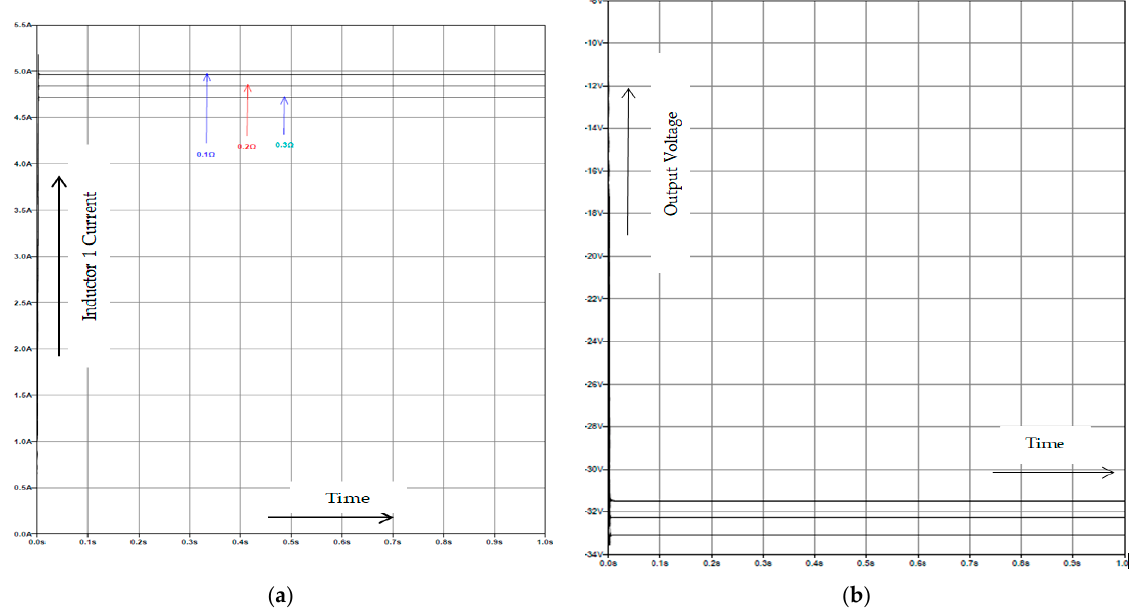
Figure 12. Variation of iL1 and V 0 with change in R L (Cuk). ( a ) Output Voltage Vs. Control Voltage, ( b ) Inductor 1 Current Vs. Control Voltage